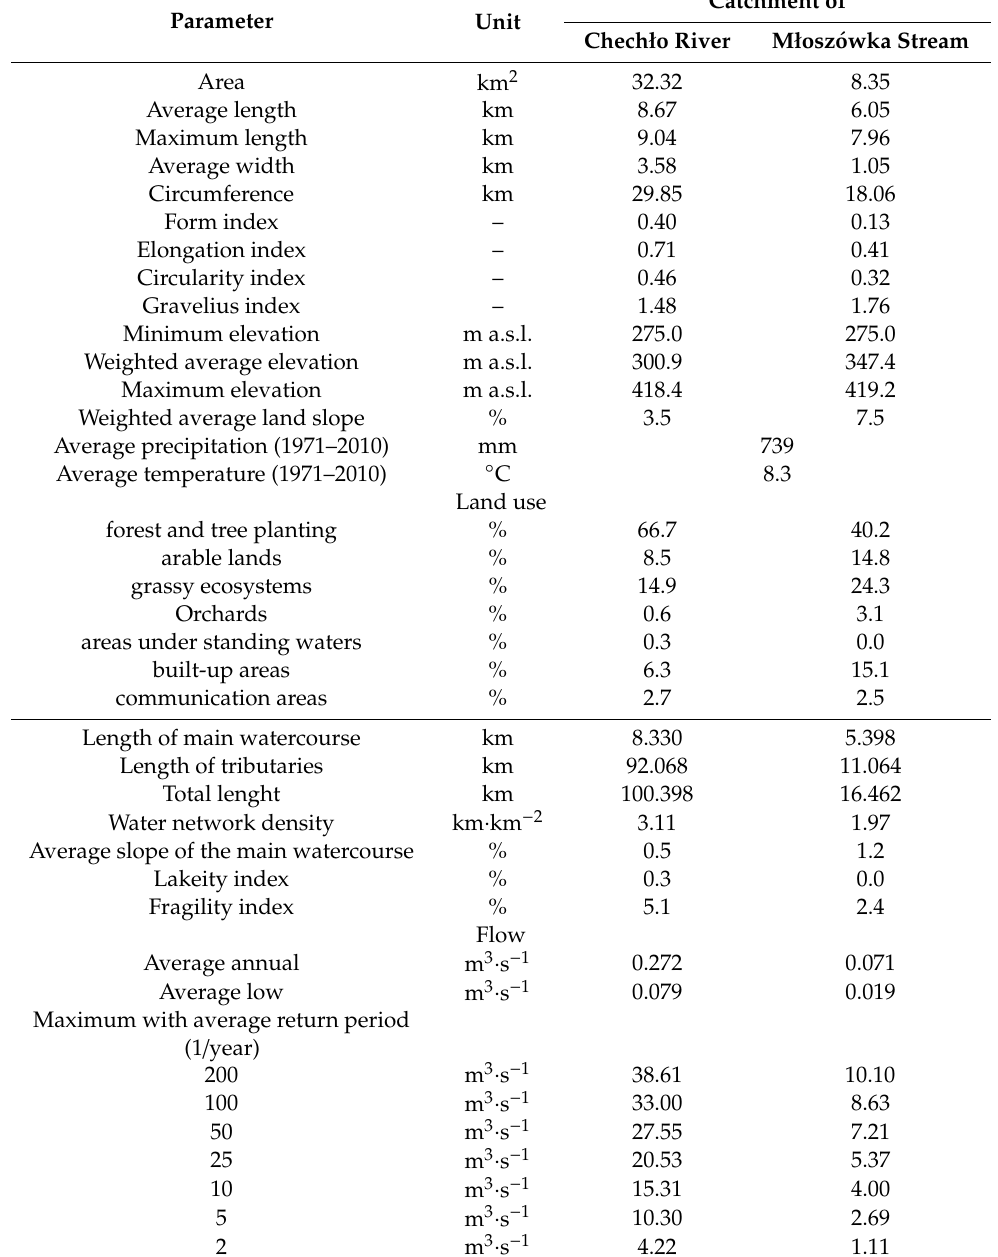
Table 1. The basic physiographic and hydrographic parameters of the study